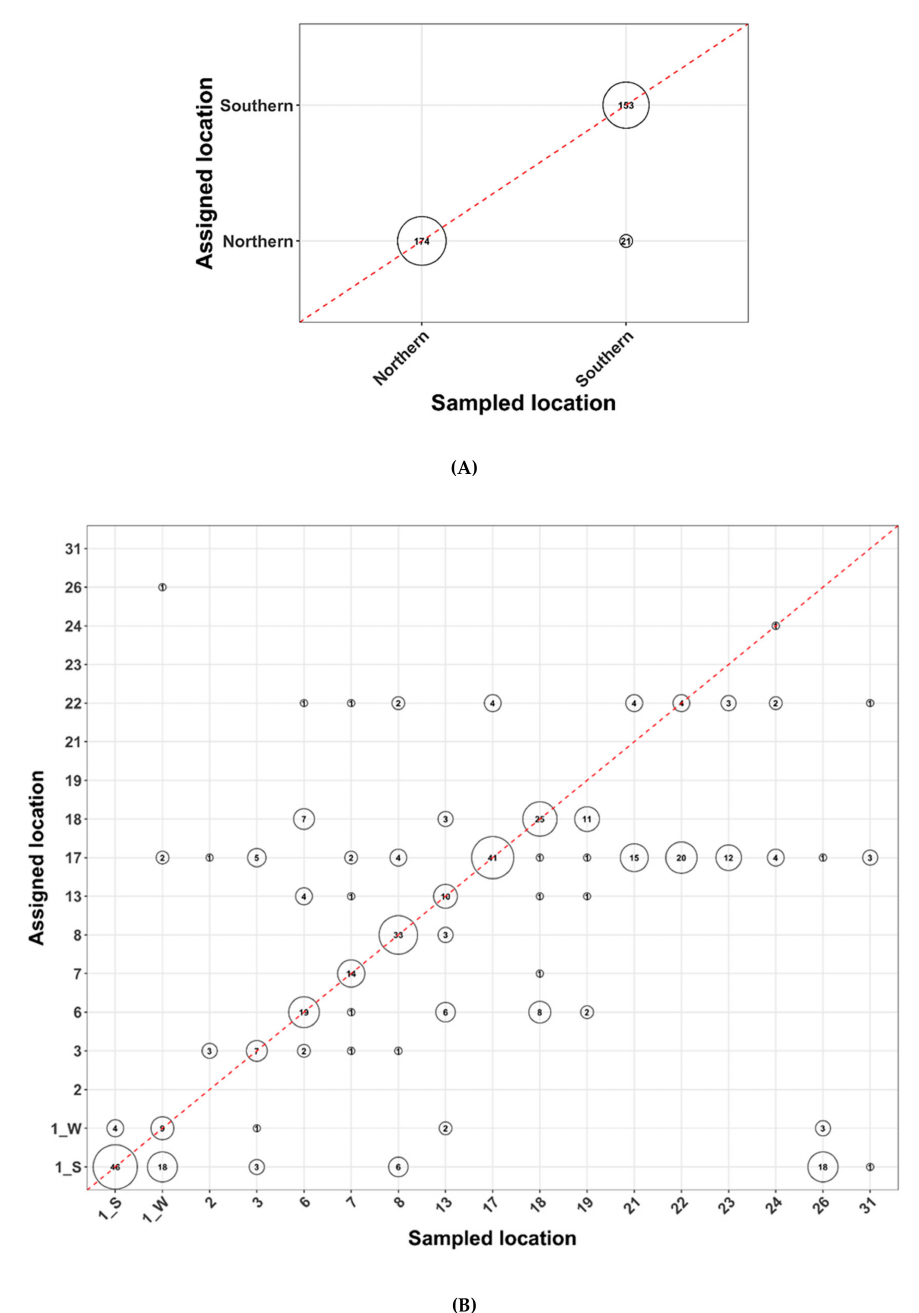
Figure 5. Assignment results with all Arctic char single nucleotide polymorphism markers (N = 3055). The circles on the red dashed diagonal represent successful assignments, and other circles display mis-assignments in which fish were not successfully assigned. Circle sizes are proportional to the number of fish. ( A ). Regional level assignment tests with Arctic char taken at random and designated either to “Northern” or “Southern” populations. ( B ). Fishing site assignment tests, with each individual fishing location indicated by a number, corresponding to the sites listed in Table 1 (with spring- and winter-netted Arctic char shown as 1_S and 1_W, respectively). Similar figures analyzed with any missing data imputed are found in Supplementary Materials Figure